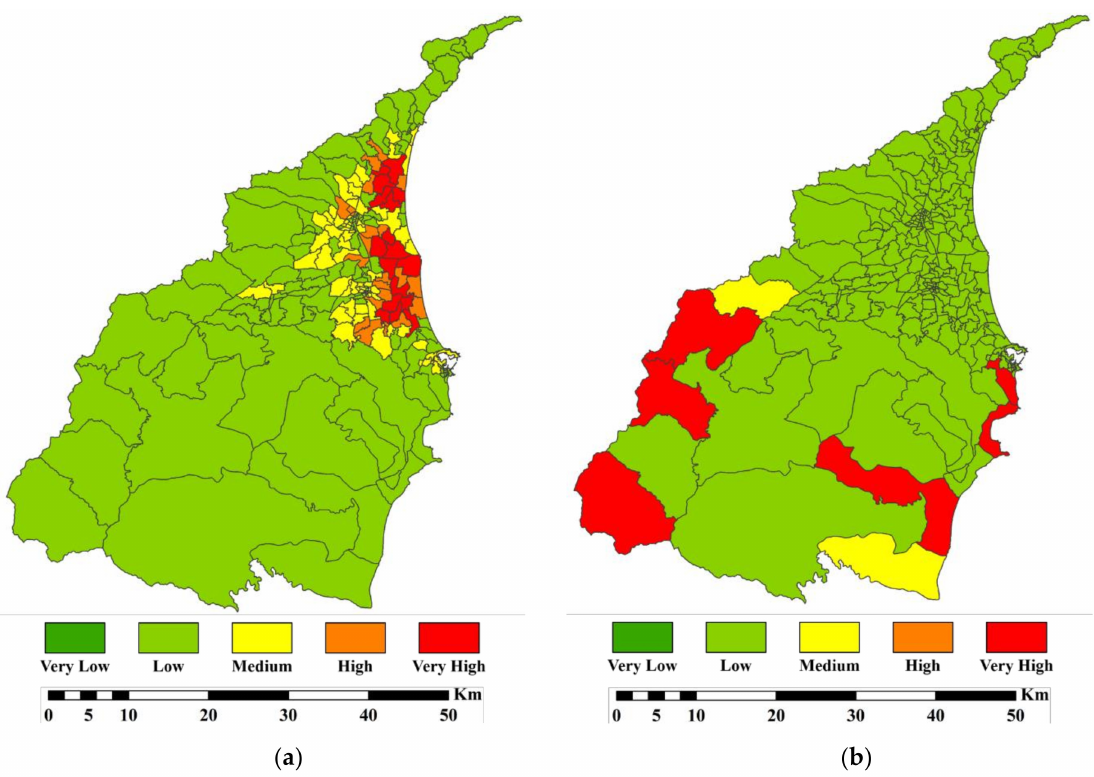
Figure 2. The distribution of flood ( a ) and debris flow ( b